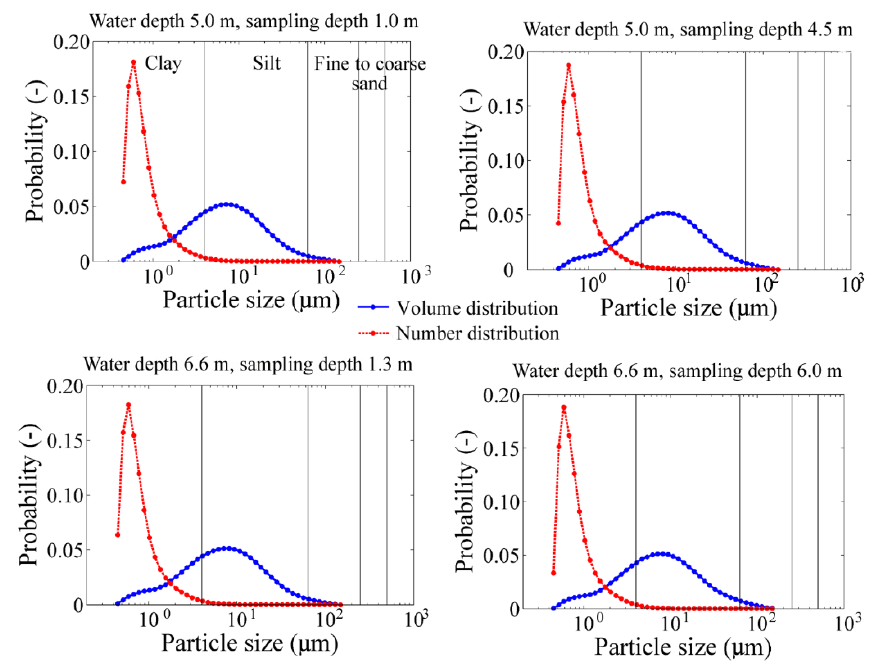
Figure 5. Subset of four PSDs from analysis of wash-load contents: point samples in two verticals with different depths in the secondary reach Colastiné of the Parana system. Table 1. Particle size distributions (PSDs) first and second order moments averaged among entire datasets.